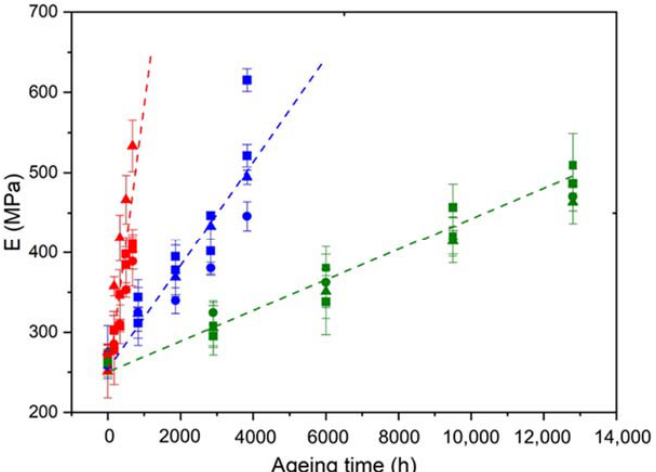
Figure 14. Changes in the elastic modulus of the Si ‐ XLPE matrix filled with 0 phr ( □ ), 25 phr (  ), and 50 phr (  ) of ATH, during its radio ‐ thermal exposure in air under 8.5 Gy ∙ h − 1 at 47 °C (green), under 50 phr ( 77.8 Gy ∙ h − 1 at 47 °C (blue), and under 400 Gy ∙ h − 1 at 21 °C (red). (cid:35) 77.8 Gy · h − 1 at 47 ◦ C (blue), and under 400 Gy · h − 1 at 21 ◦ C